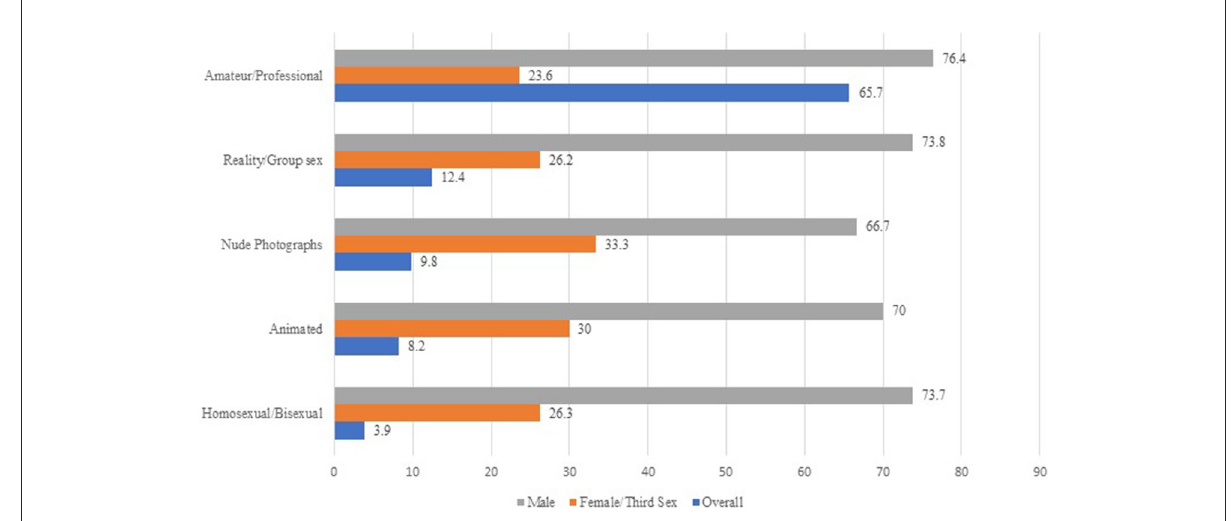
FIGURE2 Type of pornography preferred by sexes ( N =